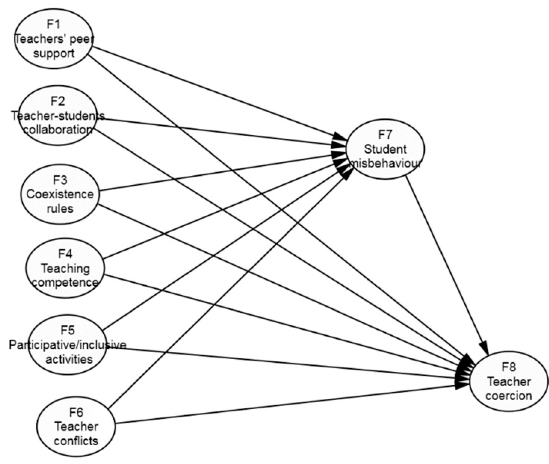
Figure 1. Theoretical model for SEM.